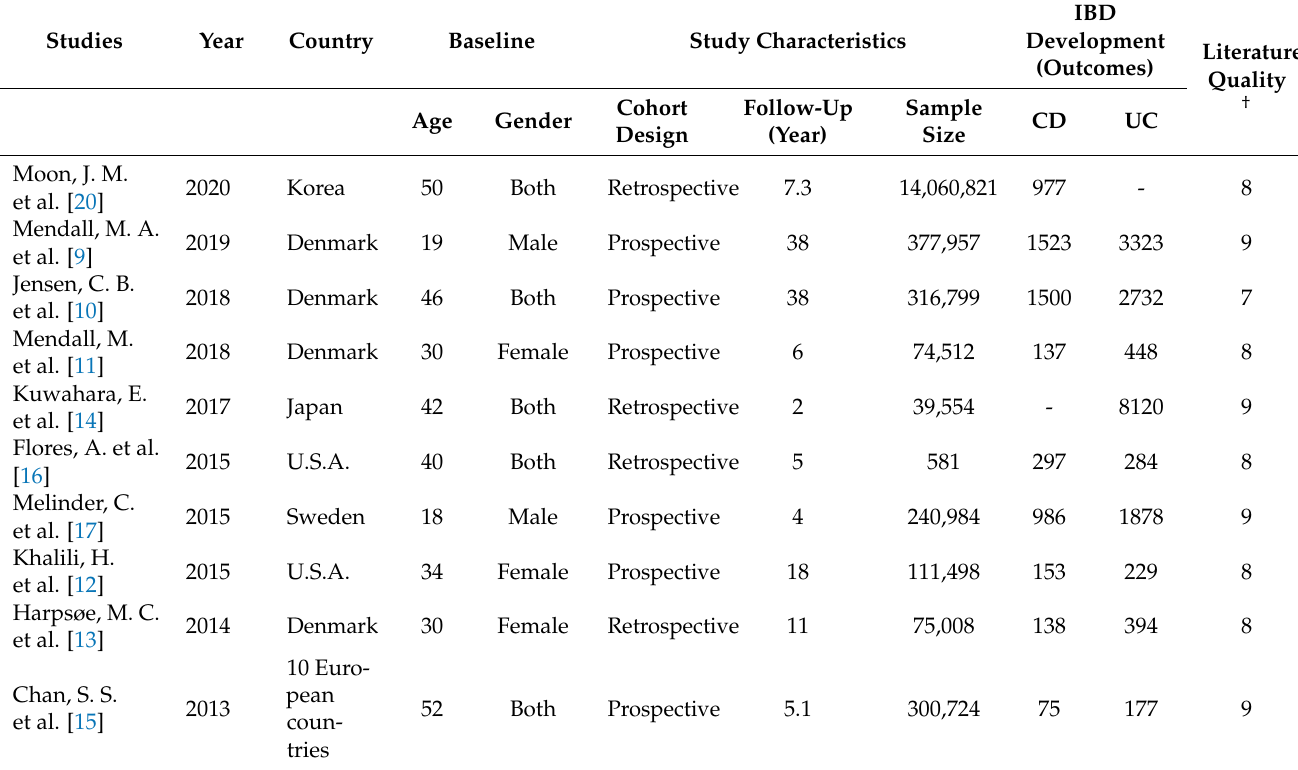
Table 1. Core characteristics of studies included in the meta-analysis [9–17,20].